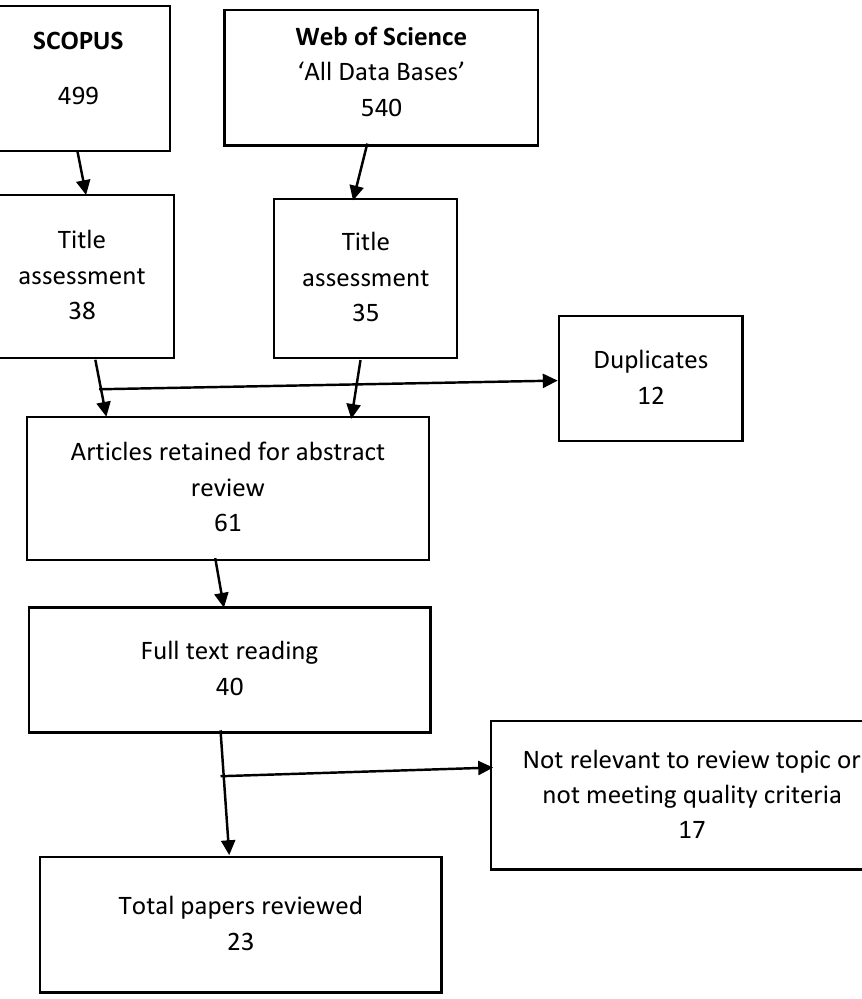
Figure 4. Flowchart of the systematic literature search based on the inclusion and exclusion criteria. Table 4. Summary of articles screened in the systematic search listed in chronological order.